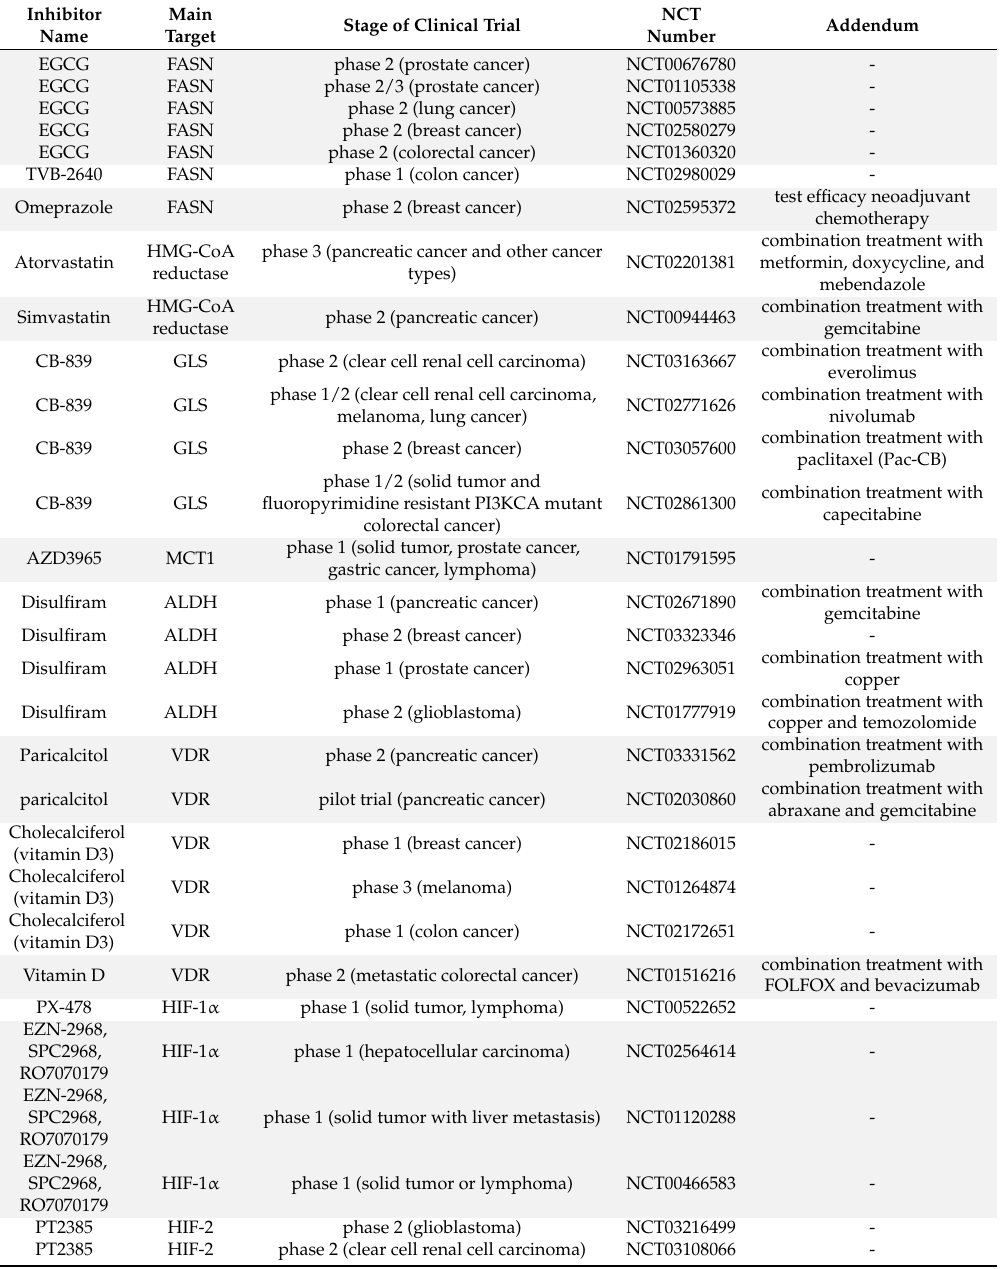
Table 1. Overview of completed and ongoing clinical trials with inhibitors blocking lipid metabolism-associated